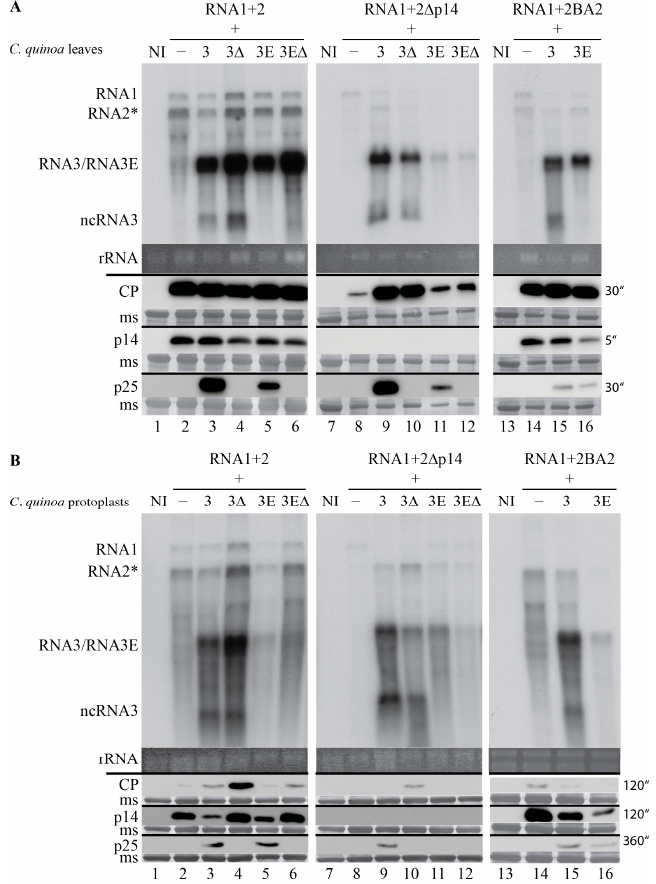
Figure 2. RNAs producing ncRNA3 species partially restore viral RNA and protein accumulation, which is lower in the absence of the p14 VSR or in the presence of the p14BA2 mutant. ( A ) C. quinoa local lesion at 7 dpi and ( B ) C. quinoa protoplast RNA and protein at 40 h post-infection were extracted and analyzed by Northern blot (upper panels) using BNYVV-specific RNA probes, and Western blot (lower panels) using anti-coat protein (CP), anti-p14 and anti-p25 sera. Exposure times for protein detections are indicated. Inoculum consisted of RNA1 + RNA2 (left panels), RNA1 + RNA2 ∆ p14 (middle panels) or RNA1 + RNA2BA2 (right panels) alone ( − ) or supplemented by wild-type RNA3 (3), RNA3p25null mutant (3 Δ ) or the same RNA species unable to produce ncRNA3 (3E and 3E Δ ). The position of the RNA species is indicated on the left. Ethidium bromide staining of ribosomal RNA (rRNA) and membrane staining (ms) were used as loading controls. Protoplast infection was performed once. Depending on the RNA combination, leaf infections were conducted twice or more and gave comparable results. NI: non-infected.